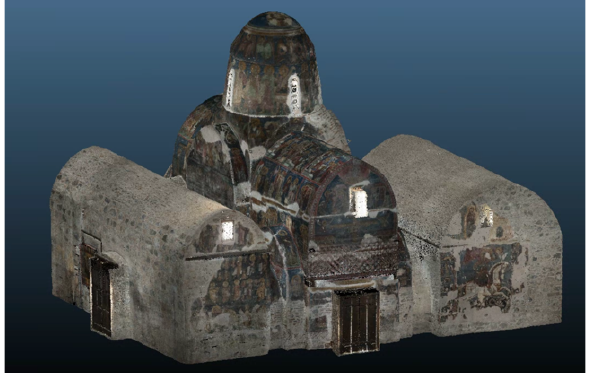
Figure 9. Timios Stavros, Pelendri, interior, RGB model.